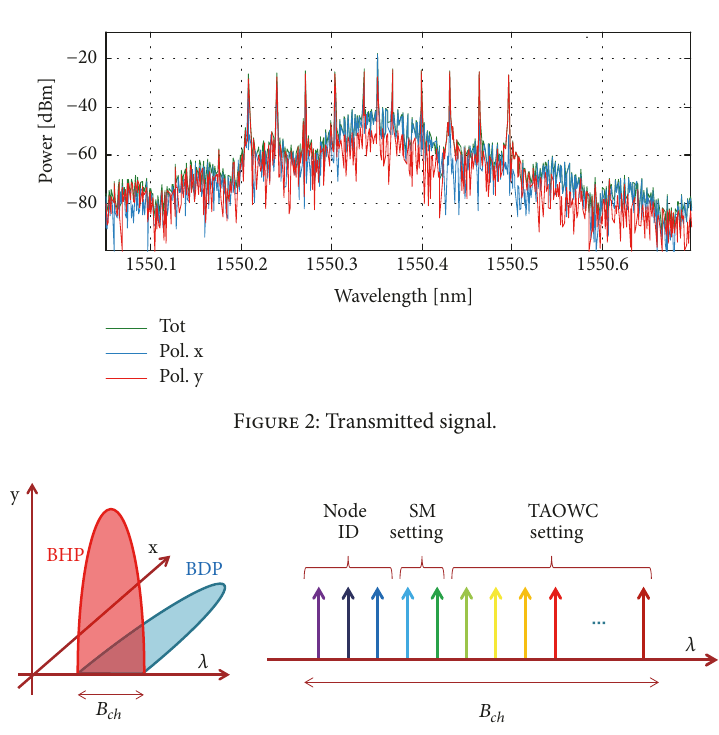
Figure 3: Burst data packets (BDP) and burst header packets (BHP)